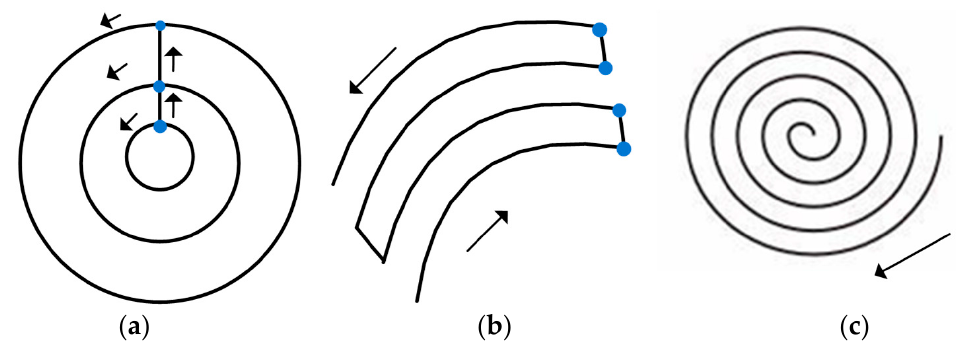
Figure 1. Toolpath classification ( a ) contour-parallel toolpath ( b ) direction-parallel toolpath ( c ) no boundary toolpath.